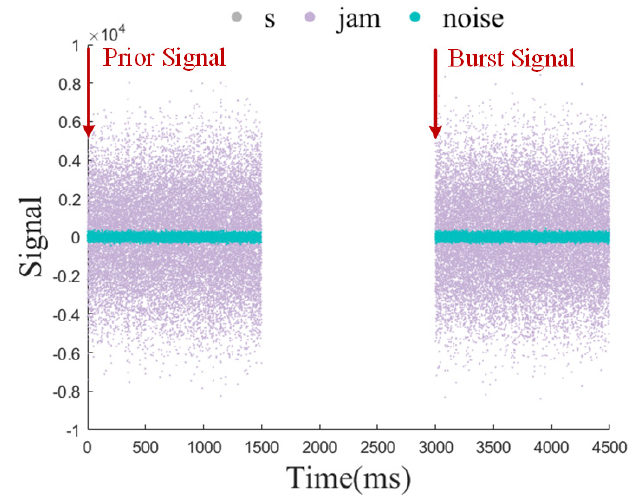
Figure 2. Time-domain diagram of the received signal.